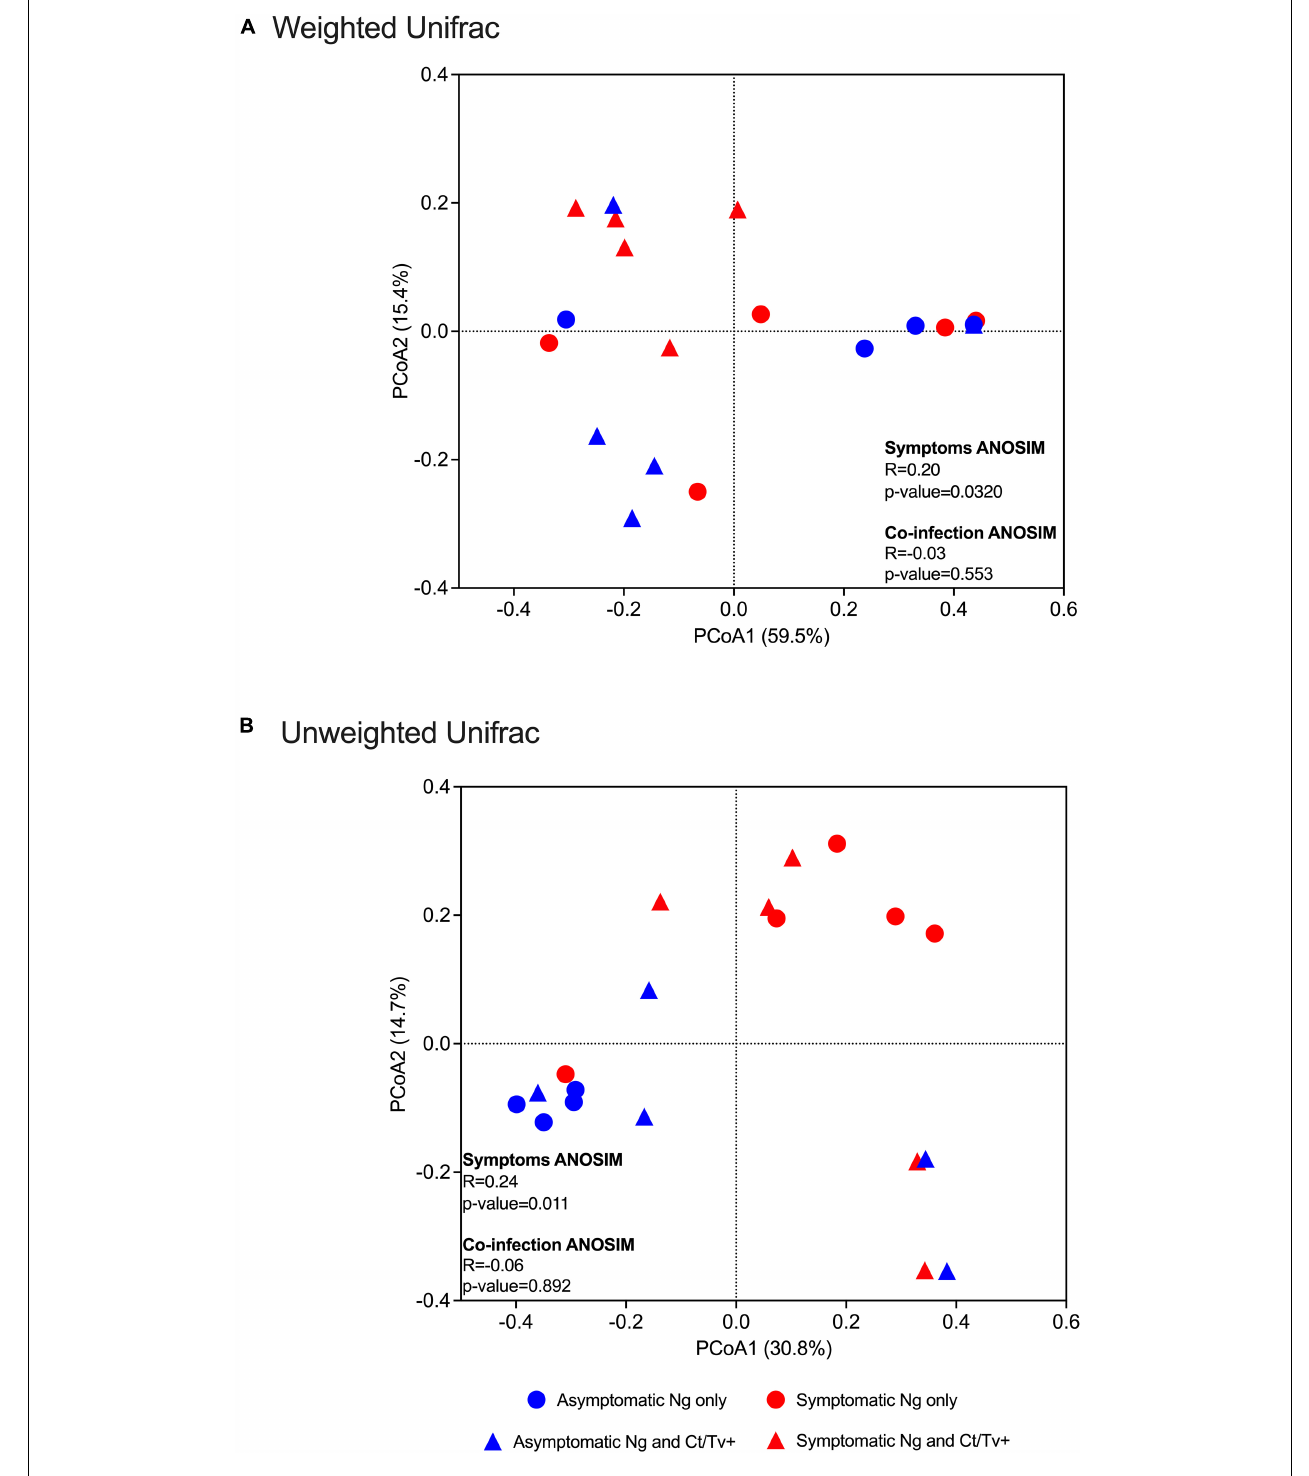
FIGURE 3 | Beta diversity analyses with respect to clinical presentation and other STI co-infection. Beta diversity estimates were calculated within QIIME using weighted (A) and unweighted Unifrac (B) distances between samples. Results were summarized and visualized through principal coordinate analysis (PCoA) in QIIME. ANOSIM tests were used to assess the strength of the clustering patterns and statistical significance. Differences between symptomatic and asymptomatic patients, but not between patients with and without C. trachomatis and/or T. vaginalis co-infection, were found, with clear separation on PCoA plots by two different methods: weighted Unifrac (ANOSIM R = 0.20, p -value = 0.032, A ) and unweighted Unifrac (ANOSIM R = 0.24, p -value = 0.011).